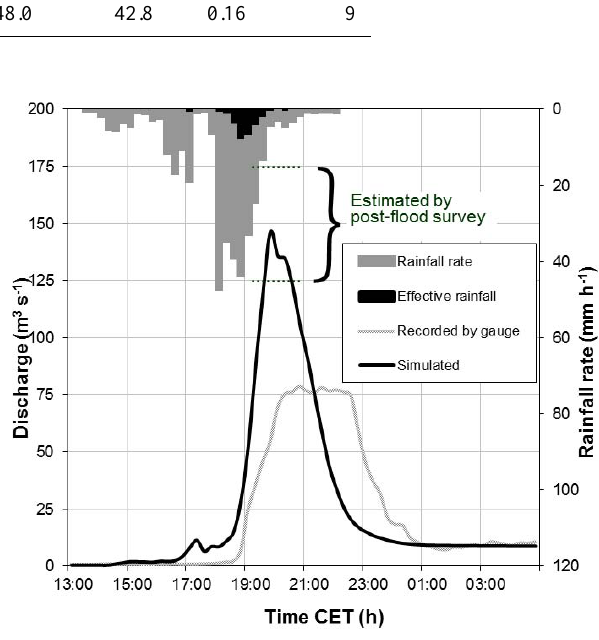
Fig. 11. Hydrograph analysis at the Rangendingen stream gauge station: estimated hydrograph based on recorded stages (recon- structed); peak flow estimated by post-event survey; model-based